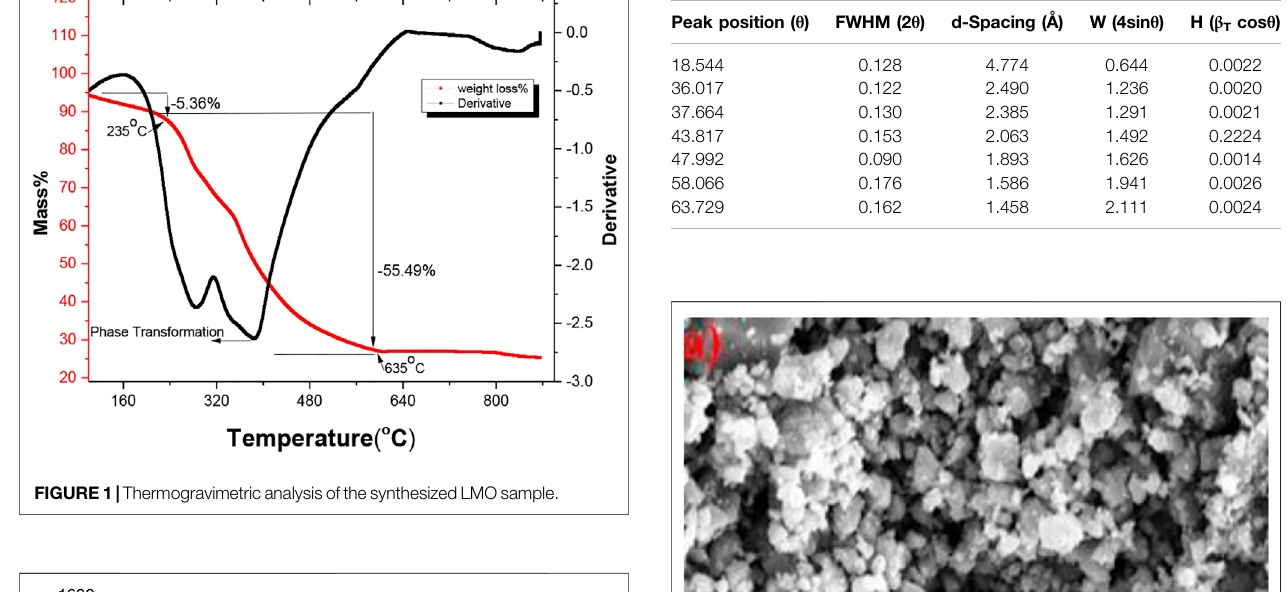
TABLE 1 | XRD parameters of the as-synthesized sample.